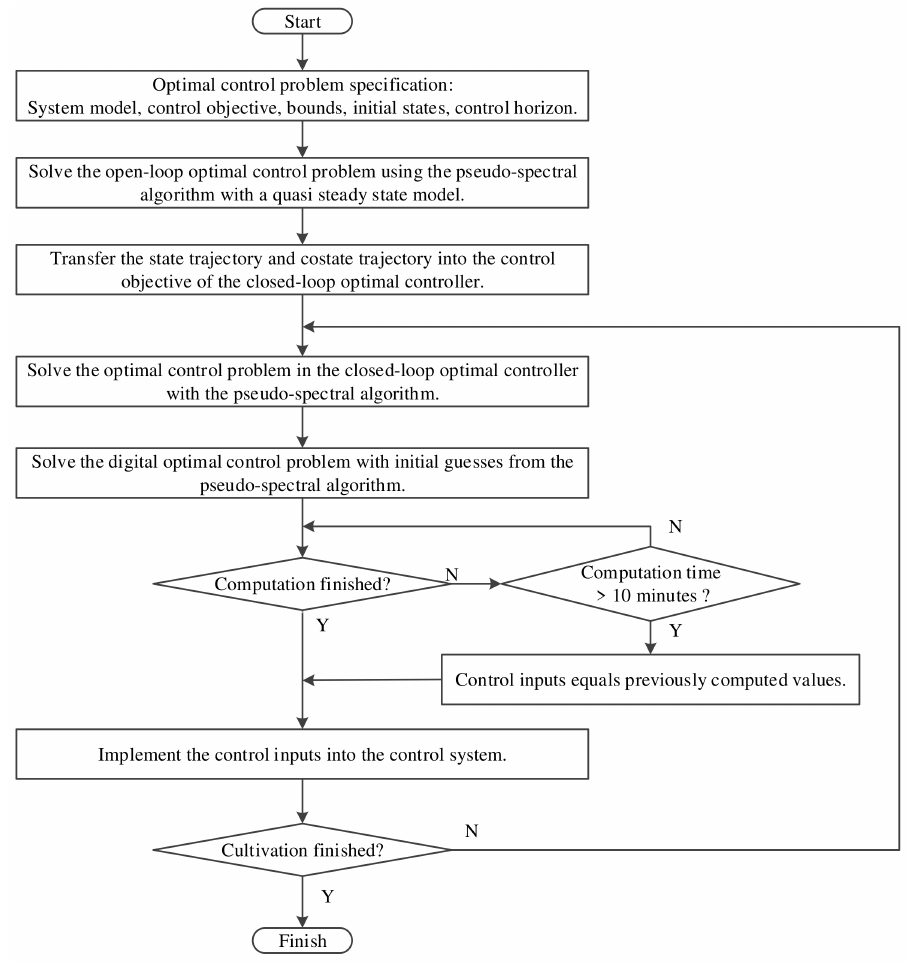
Figure 2. Flow chart of the optimal control